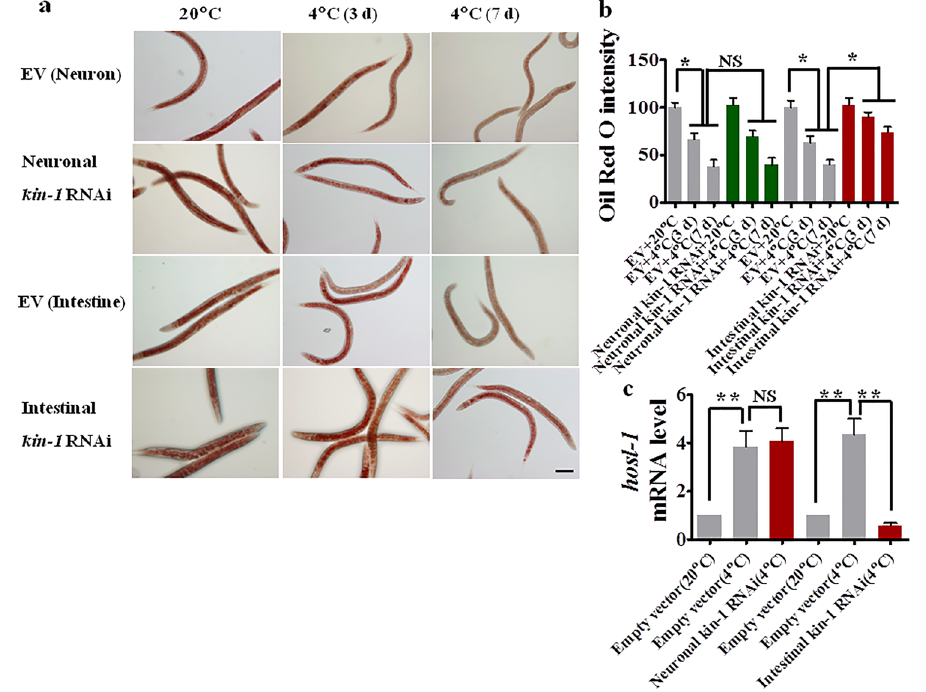
Figure 6. KIN-1/PKA in the intestine regulates the lipid hydrolysis during cold stress. ( a ) A representative image of lipid droplets using Oil Red O staining. Scale bar, 100 μ m. ( b ) Lipid hydrolysis was significantly inhibited by intestinal-specific kin-1 ( RNAi ). * P < 0.05. ( c ) The mRNA levels of hosl-1 were down-regulated in worms subjected to intestinal-, but not neuronal-, specific kin-1 ( RNAi ) after cold exposure. * P < 0.01.NS, not